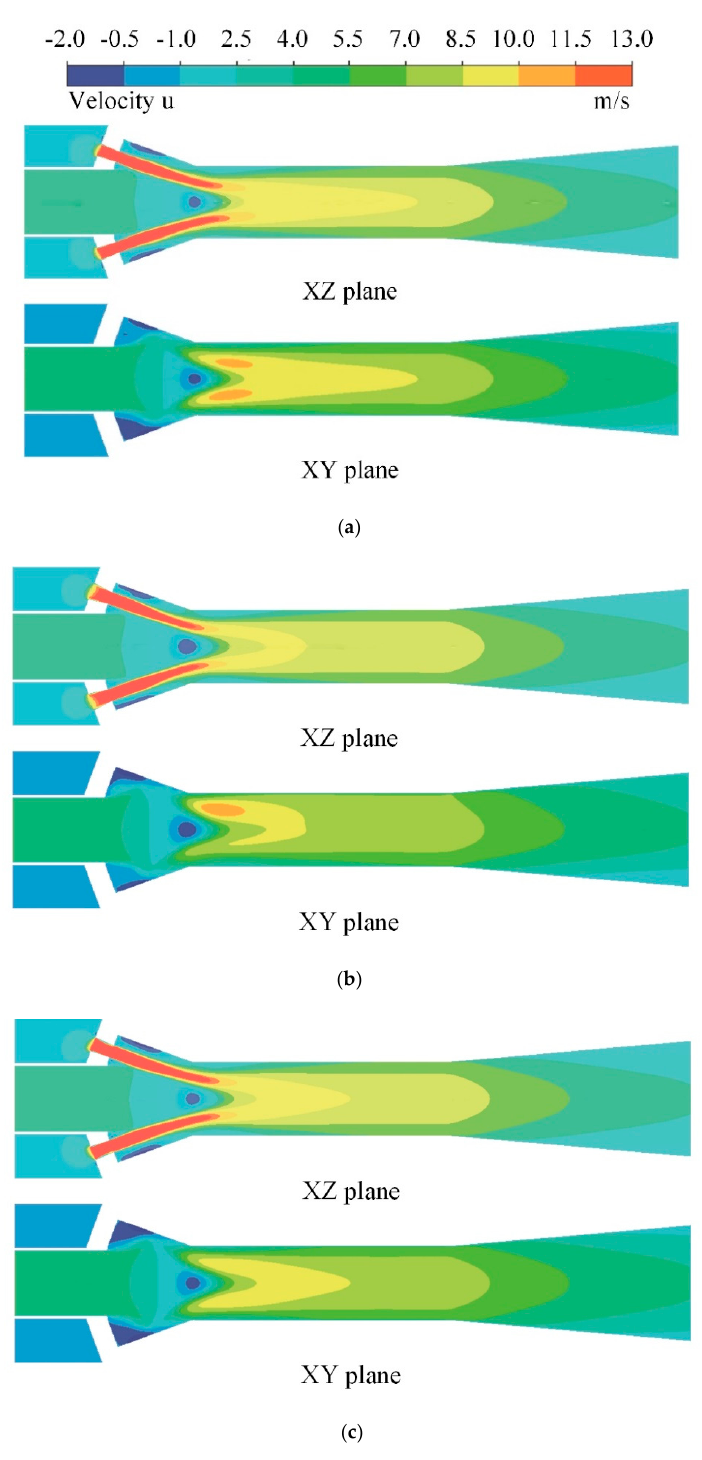
Figure 5. The distribution of the axial velocity of the jet pump with different nozzle section geometries. ( a ) Square nozzle; ( b ) Circular nozzle; ( c ) Triangle nozzle.